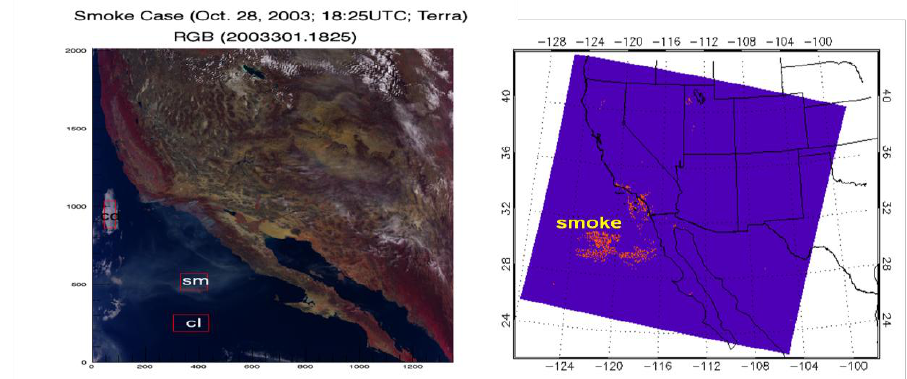
Figure 19. A RGB false color image of a Terra MODIS granule on October 28, 2003 at approximately 18:25 UTC in the left panel (cd, cl, and sm represent cloud, clear-sky, and smoke, respectively). The results of the smoke detection are in the right panel where pixels flagged as smoky are